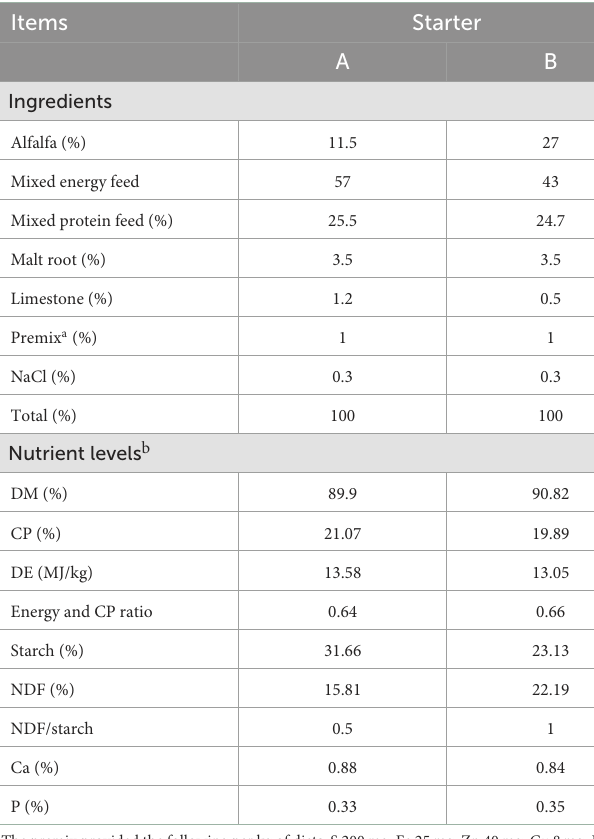
TABLE 1 Composition and nutrient levels of starter (air-dry basis)